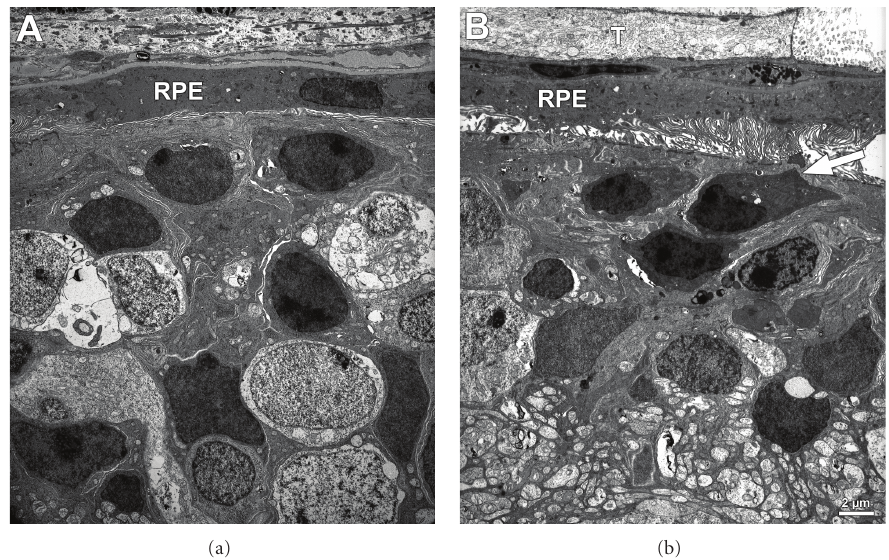
Figure 5: Ultrastructure of nontapetal (a) and tapetal retina (b) from the same dog shown in Figure 4. Note the severely disorganized outer and inner retinal cell layers and structures. The RPE cell layer appears preserved, however. In (b) there is relative sparing of the retina with some minor remnants of photoreceptor nuclei with inner segments (arrow) and an abundance of RPE apical microvilli. RPE: retinal pigment epithelial cells, T: tapetal cells. Bar depicts magnification which is the same for (a) and (b).